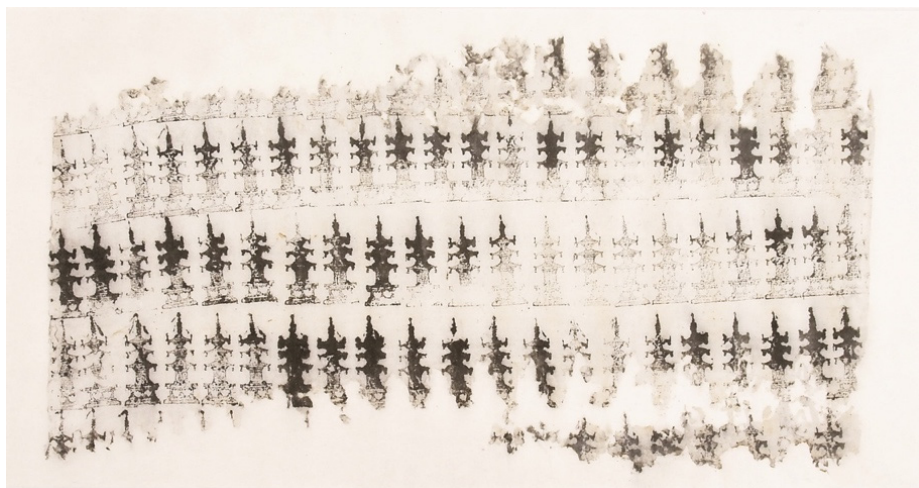
Figure 7. Pagoda-stamped sheets, Unified Silla, eighth-to-ninth centuries, H. 24.5 cm, Hwa ŏ msa Buddhist Museum [©CBM].